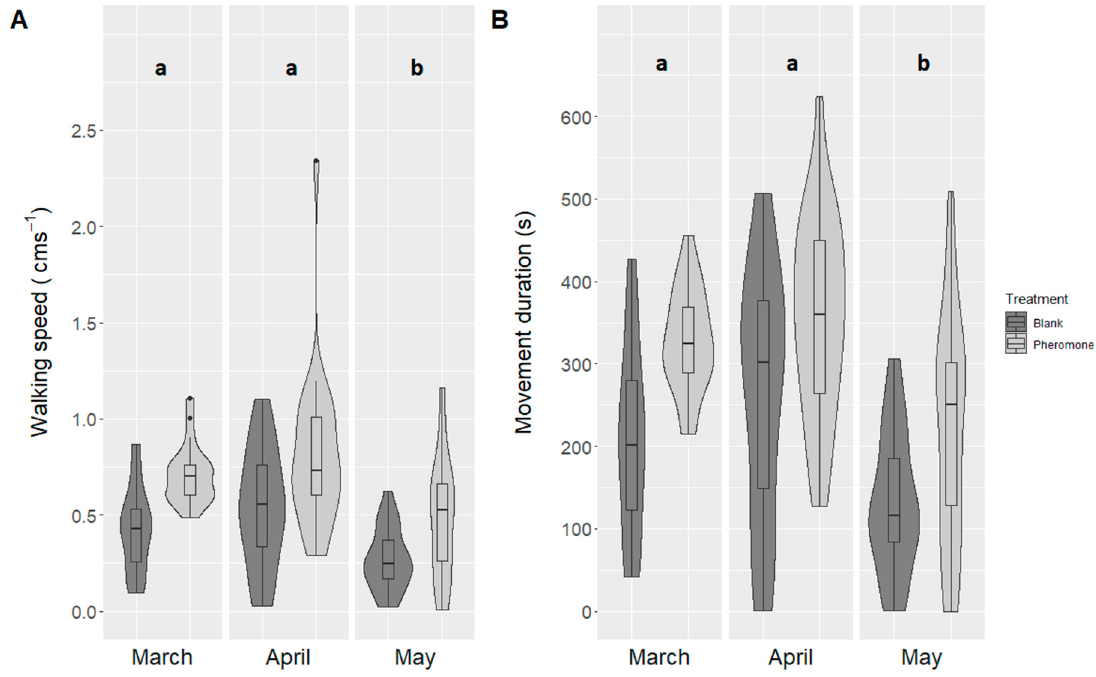
Figure 3. Impact of collection month on male Agriotes obscurus click beetle activity in response to pheromone treatment for beetles. Total beetles tested (number of batches with 1–5 beetles in a batch / replicate): March: 220 (44); April: 188 (47); May: 195 (48). Activity is depicted by mean ( ± SE) ( A ) walking speed and ( B ) movement duration. Letters represent significance at p < 0.05, as assessed by Tukey’s HSD.